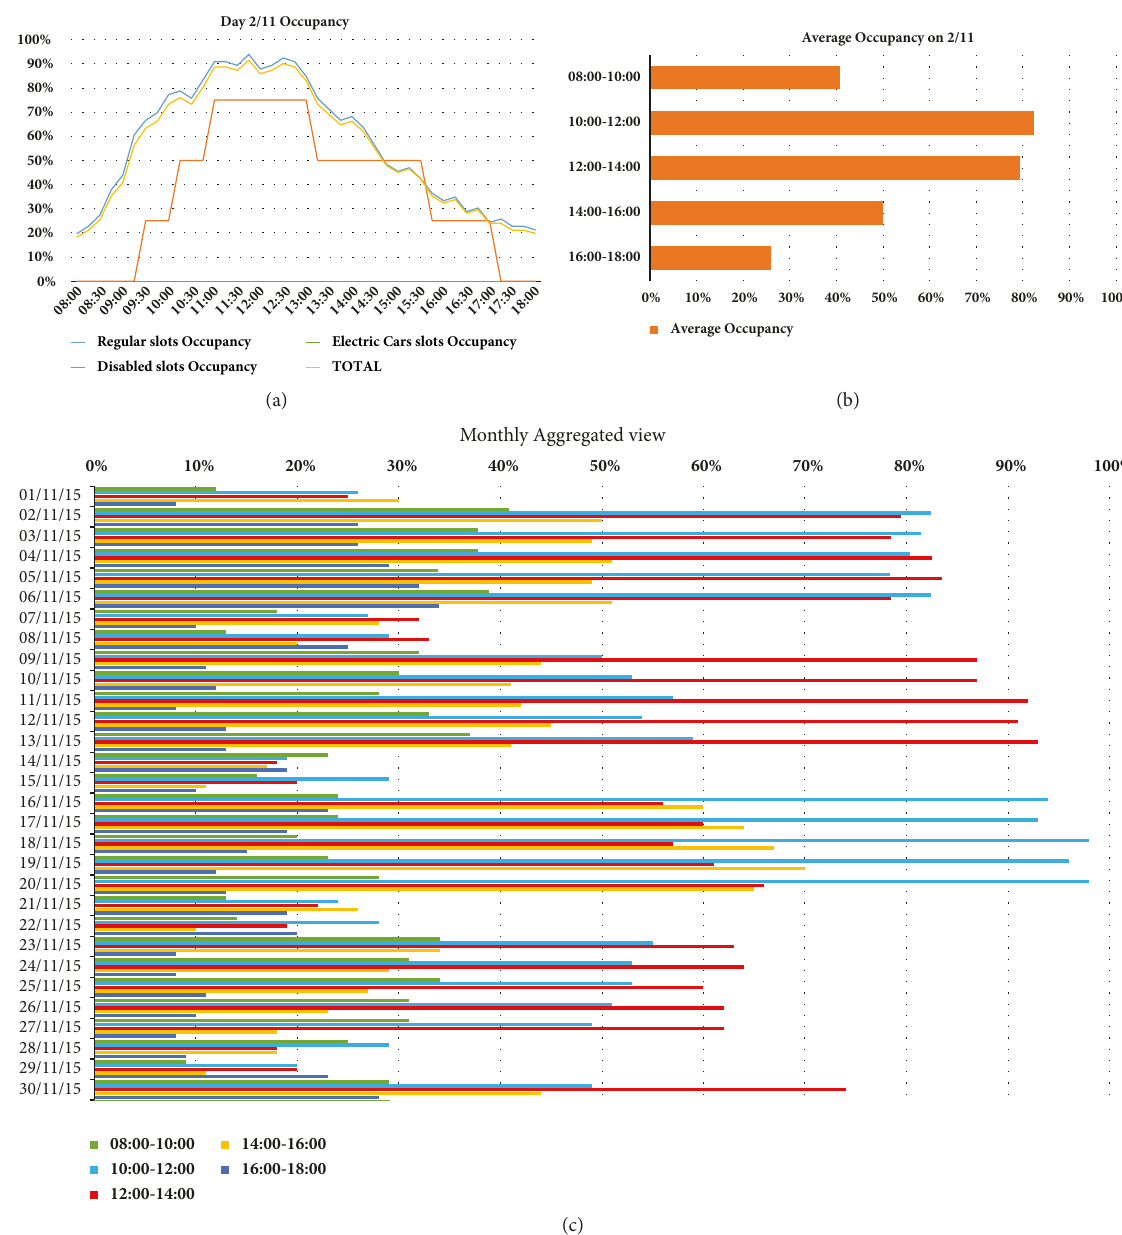
Figure 11: Results: (a) Occupancy status of the parking on November 2, 2015, (b) parking lot occupancy on November 2, 2015 aggregated by time slots, and (c) aggregated occupancy data by time slots for the month of November. Aggregated occupancy data by time slots for the month of